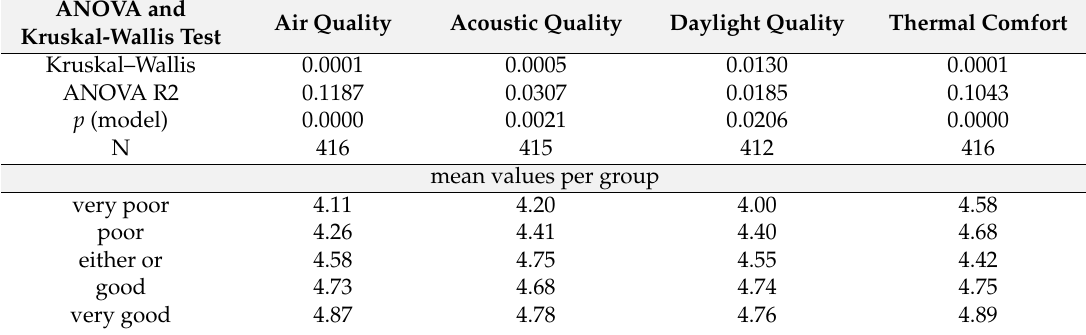
Table 6. ANOVA test for difference in means for general satisfaction and perception of indoor environmental quality.